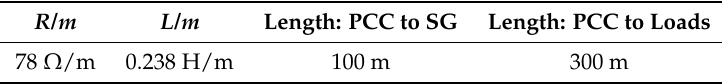
Table 2. Transmission lines parameters.